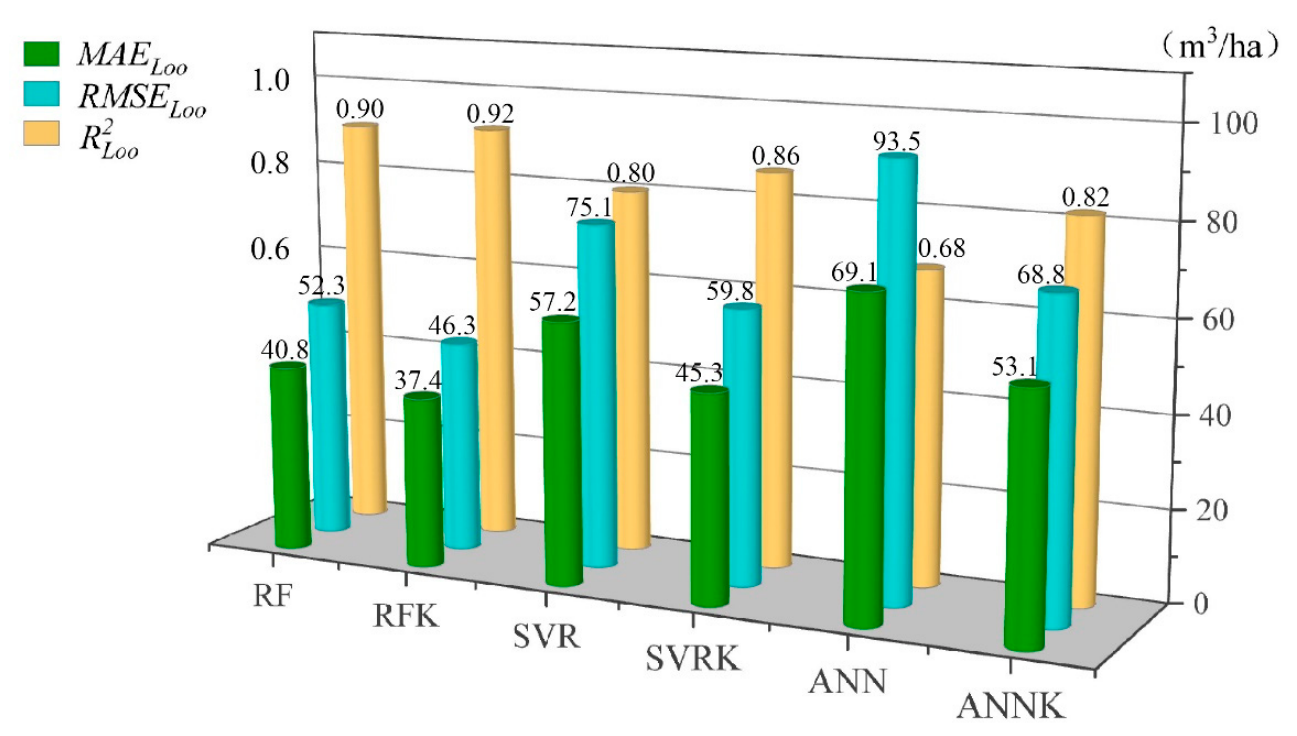
Figure 10. Model estimation evaluation indicators. The bar chart is a visual analysis of the data in Table 5; the three colors indicate the three indicators MAE Loo , RMSE Loo , and R 2 . The models are analyzed by comparing the heights of the bars in the chart. Table 4. Parameters of ordinary Kriging models of residuals and their accuracy. Residual Spherical